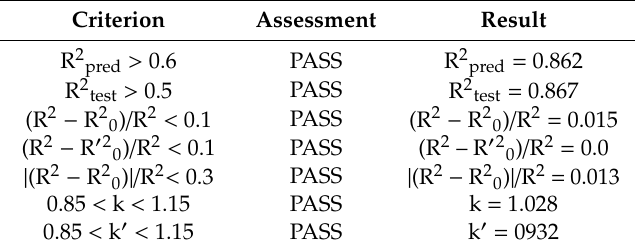
Table 3. Enalos Model Acceptability Criteria KNIME node screenshots for the CoMFA model.